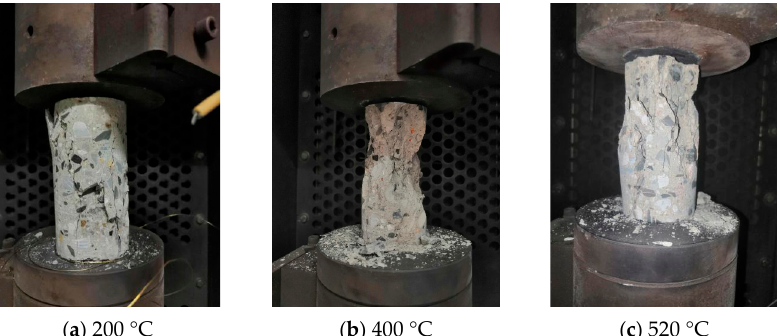
Figure 5. Typical damage morphology of concrete specimens immersed for 60 h at different tem- peratures. During the heating process of the specimen, the color of the specimen changed with the rise in temperature. The color of the specimen did not change much before the tem- perature reached 200 °C, but when the temperature reached 400 °C and 520 °C, the speci- men presented a light yellow and gray-white color, respectively. After the specimen reached the predetermined temperature, there were no obvious cracks before loading. However, in some reports [34] of high-temperature experiments of concrete, high-temper- ature burst occurred before the temperature reached 500 °C. This may be due to the fast heating rate and large volume of the specimen, which lead to uneven temperature distri- bution and large temperature gradient inside the specimen. The thermal stress exceeds the tensile strength of the concrete itself. In this case, the specimen may undergo high- temperature burst. In addition, the volume of fragmentation after specimen destruction decreased with the increase in experimental temperature. 3.2. Temperature Softening Effect of Compressive Strength of Dry Concrete The compressive strength of concrete materials shows a significant softening effect at high temperatures, and the effect of temperature on the strength of concrete materials is generally characterized by the variation pattern of softening factor, K T , with tempera- ture. The temperature softening factor, K T , of compressive strength is often defined as the ratio of the high temperature quasi-static uniaxial compressive strength, σ T , of air-drying concrete to the normal temperature quasi-static uniaxial compressive strength, σ 0 , i.e., K T = σ T / σ 0 . In this study, the experimental data of the temperature softening factor, K T , with tem- perature for air-drying concrete specimens were obtained from the above experiments, as shown in Figure 6. The experimental data are basically within the discrete range of the existing experimental results [10–29], and are in good agreement with the K T –T curves obtained by Ping Li [30] by summarizing and analyzing the uniaxial quasi-static compres- sion experimental data of concrete materials at different temperatures in recent decades. It can be observed that the compressive strength of concrete materials shows a nonlinear monotonic decrease with the rise in temperature.